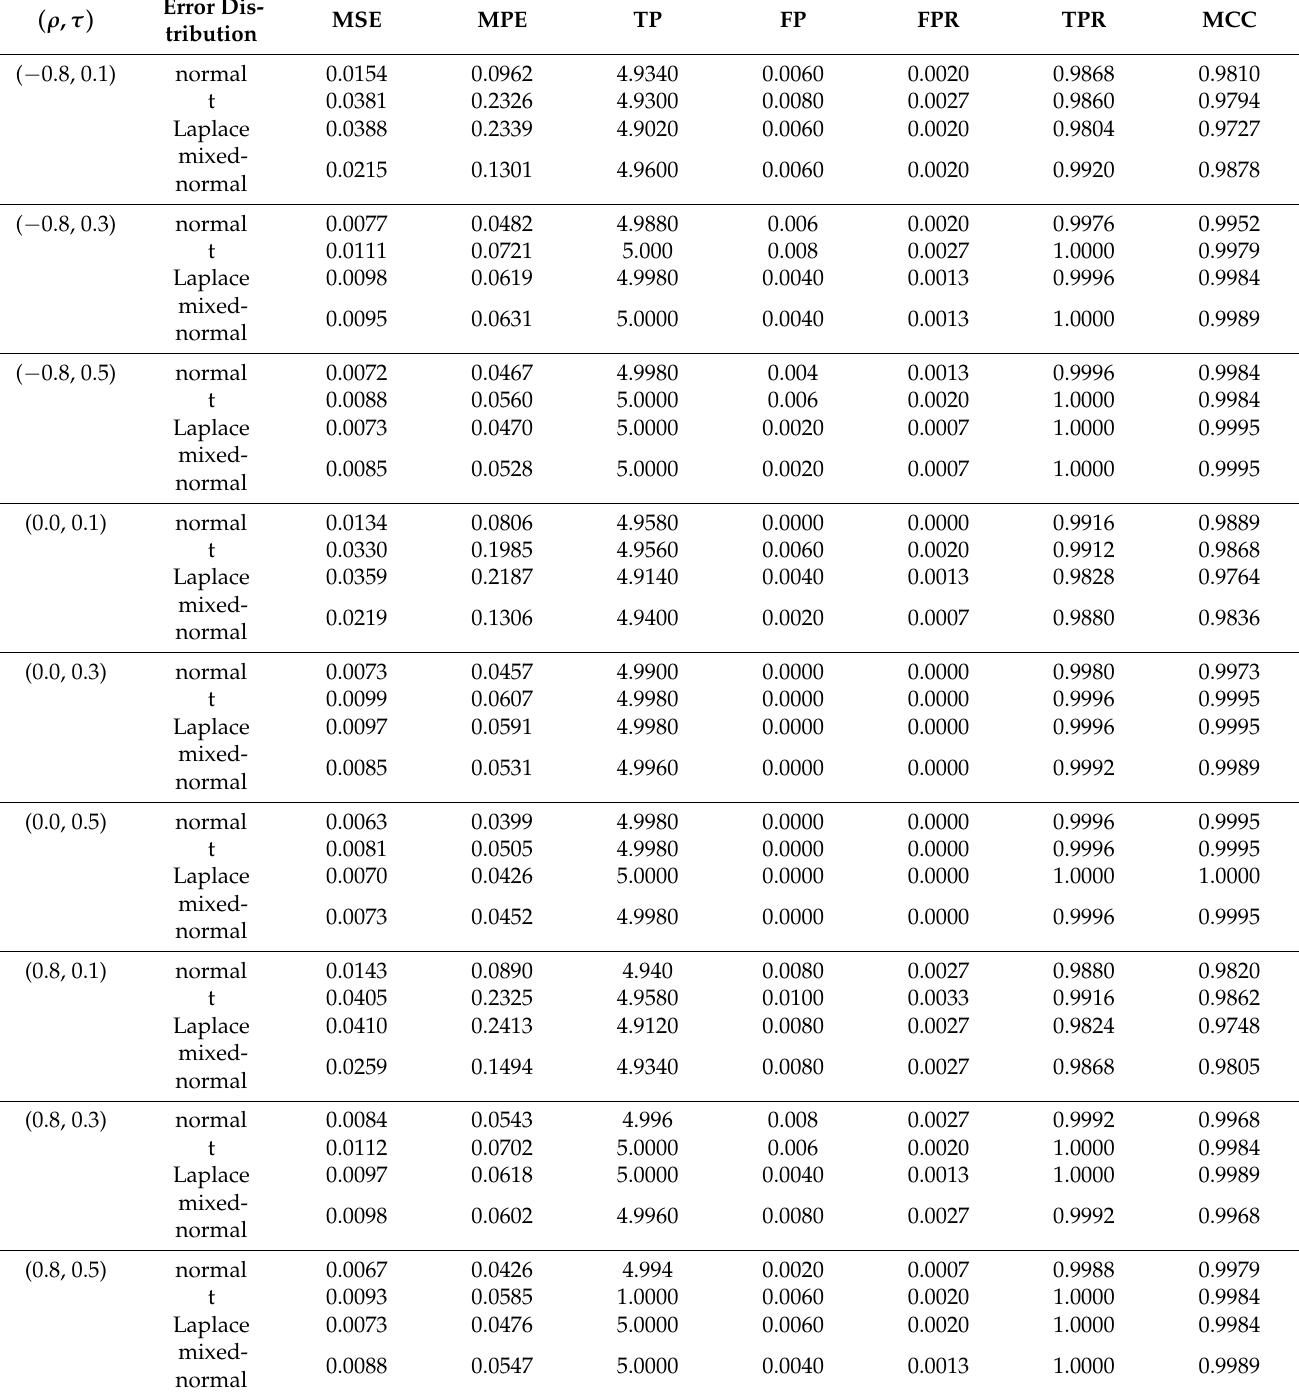
Table 2. Numerical results of the simulation study under Scenario